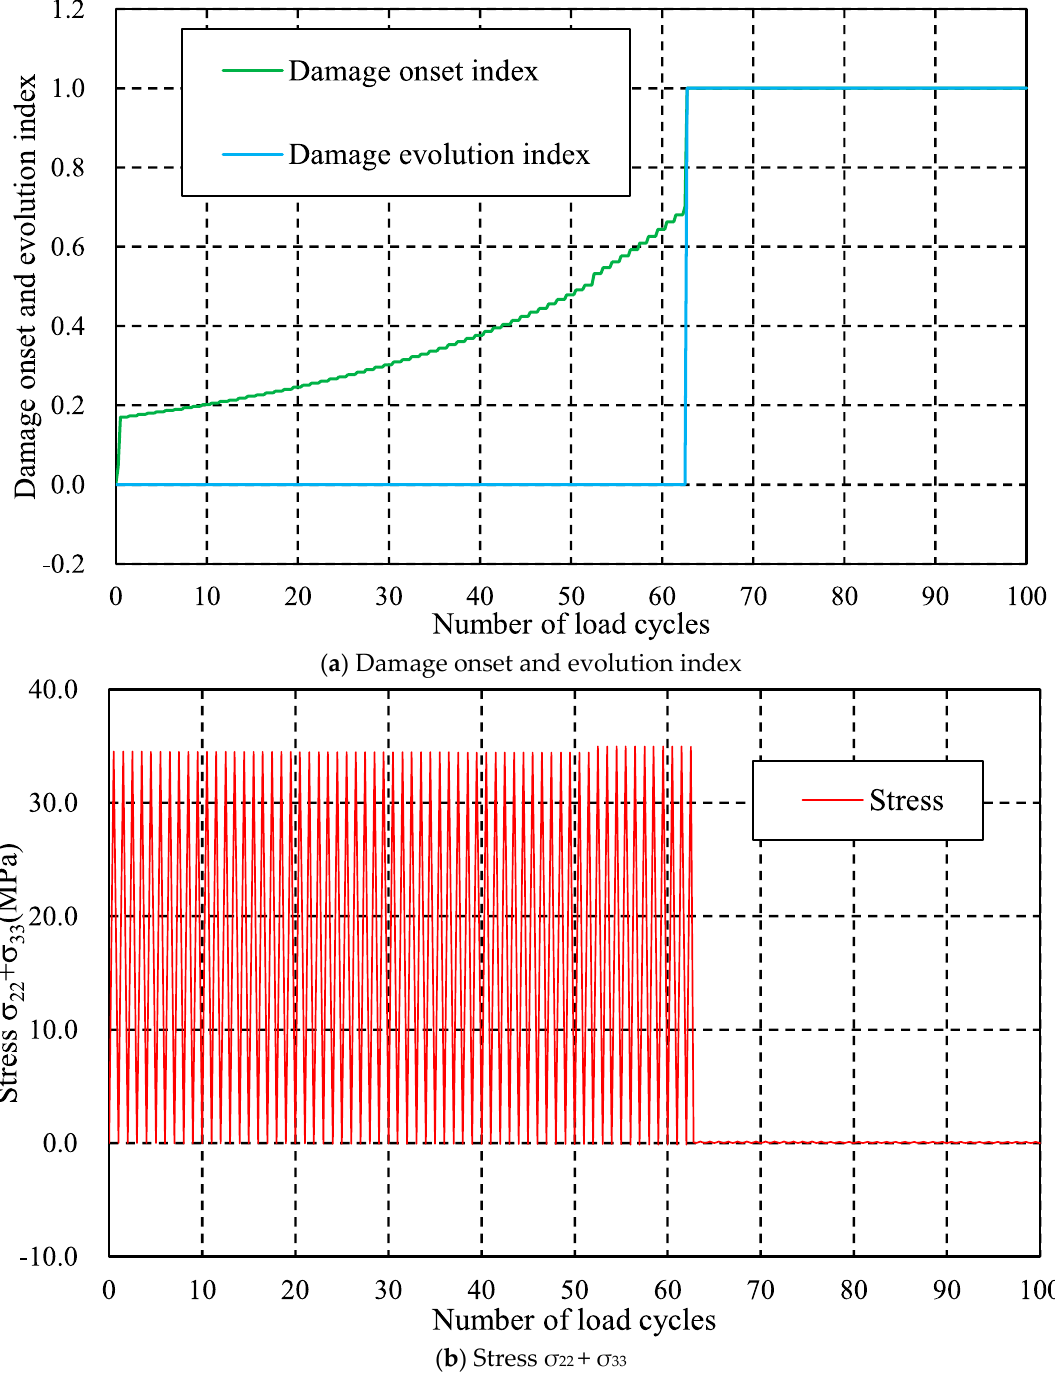
Figure 12. Evolutions of damage onset index, damage evolution index and stress σ 22 + σ 33 at first crack when the strain boundary condition is 0.6% and load frequency is fixed at 5 Hz.